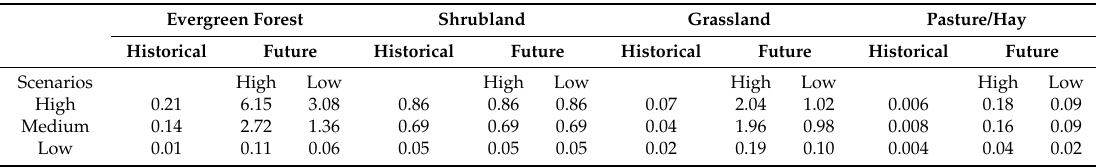
Table 3. Suitability category with their respective historical and future rate of change (%) on annual basis. Evergreen Forest Shrubland Grassland